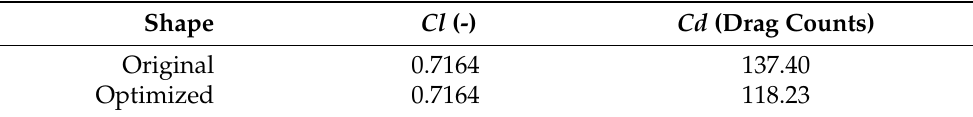
Table 4. Aerodynamic coefficients for the optimized airfoil’s